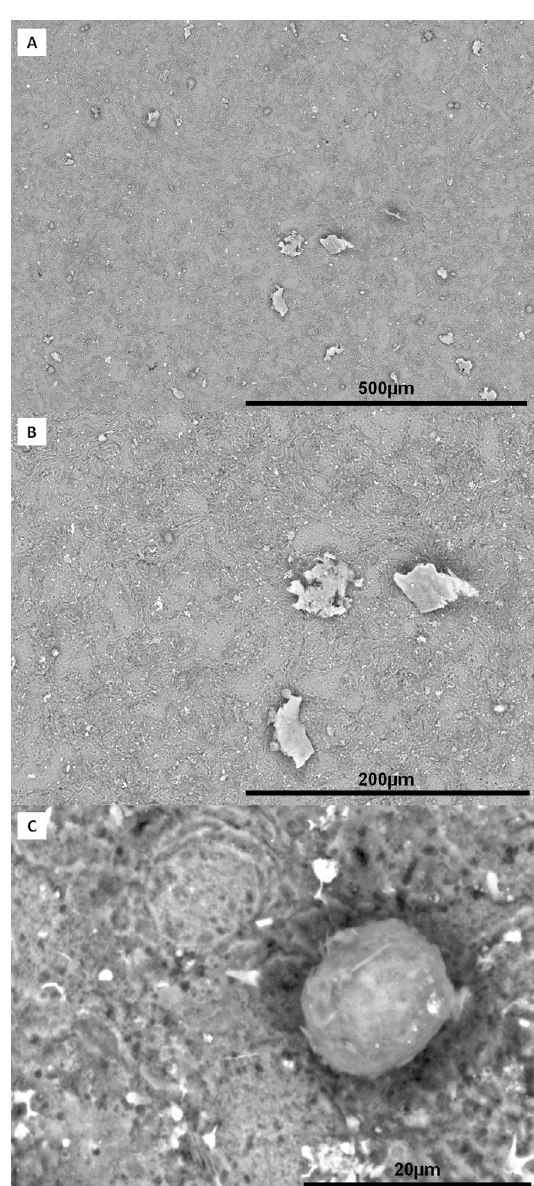
Figure 3. SEM images of EAFD (A), high-magnification SEM images of EAFD (B) and EDS spectra of EAFD particles (C).